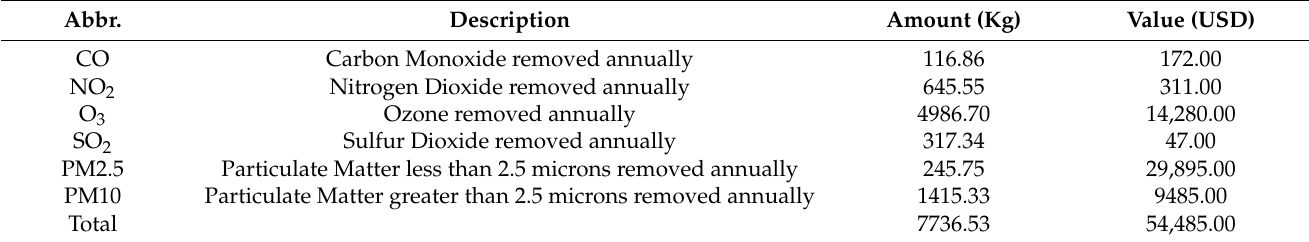
Table 5. Removal of contaminants associated with the trees in Mirador Sur